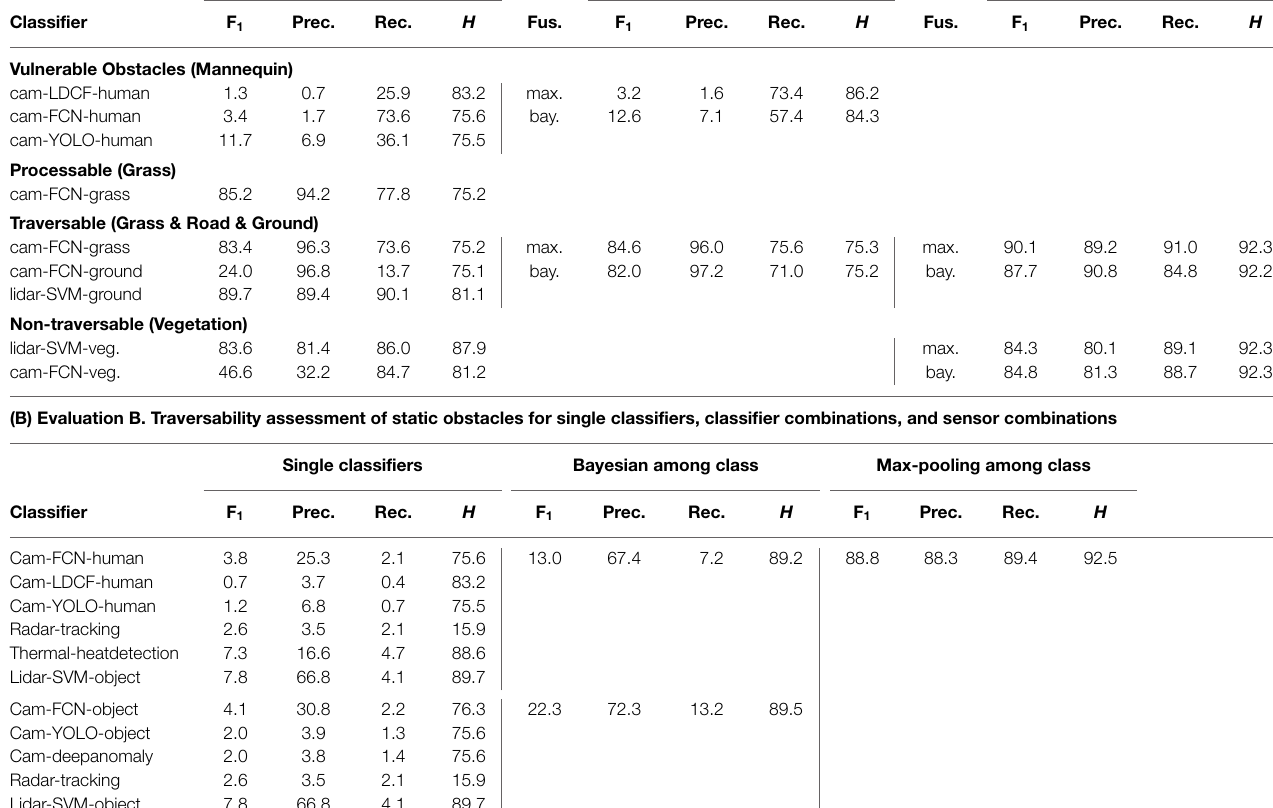
Single classifiers Fusion among class Fusion among sensors